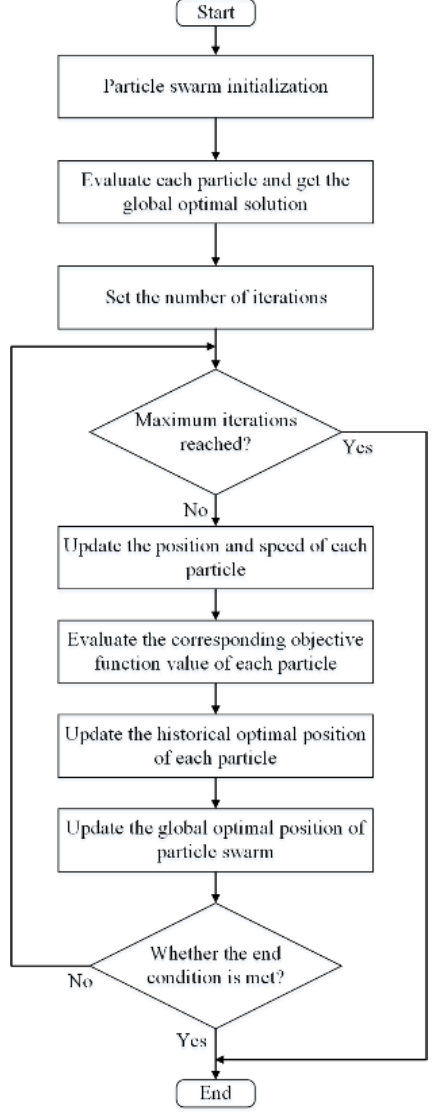
Figure 3. Flowchart of PSO algorithm.